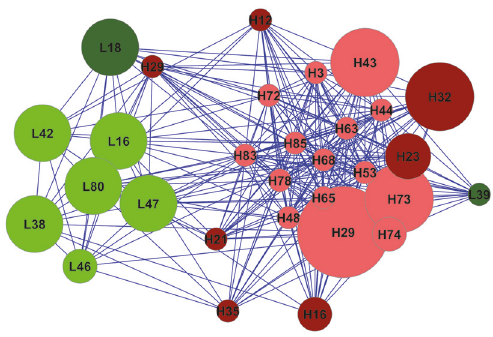
Figure 6: Prediction of seroresponse to TIV vaccination. The graph represents sample classification by means of the 207 transcripts biomarker as in Figure 2, but here the node size encodes the titer response score (bigger nodes correspond to higher indices, as displayed in Figure 5). Nodes represent subjects and the length of connecting edges is proportional to the distance between subject signatures. Node colors indicate subjects class (green for low responders and red for high responders); darker colors represent samples included in the validation set (2007-2008 TIV campaign, set #1), while lighter colors represent samples in the training set (2008- 2009 TIV campaign, set #2). Node labels indicate the sample class (H for high responders and L for low responders) and the sample